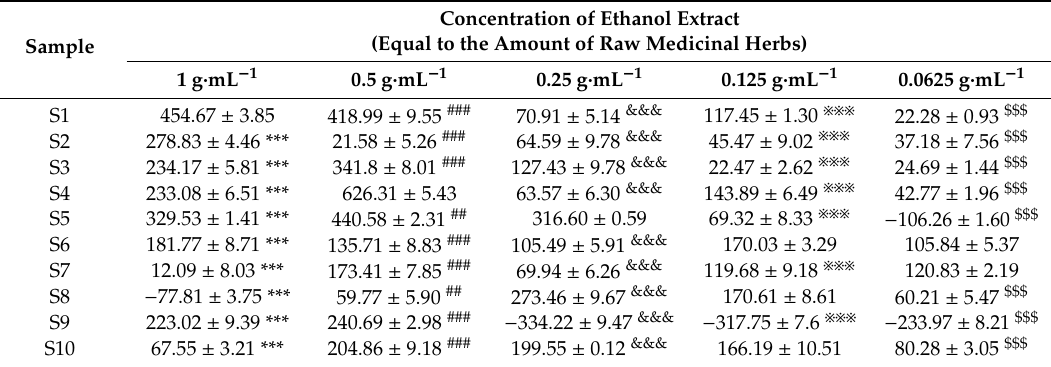
Table 1. Activation rates of tyrosinase in ethanol extracts of di ff erent batches of P. corylifolia